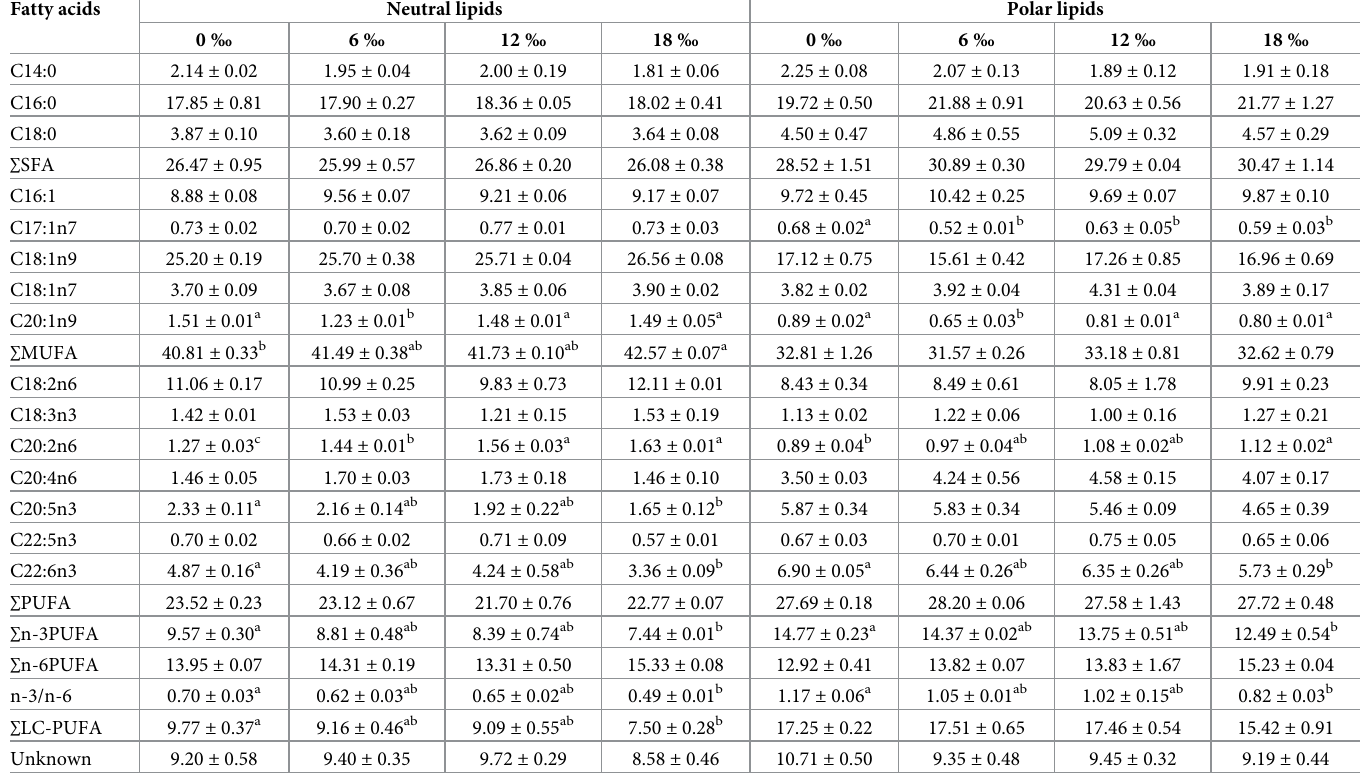
Table 4. The principal fatty acid profiles (% total fatty acids) of the neutral lipids and polar lipids in the hepatopancreas of adult male E . sinensis . Fatty acids Neutral lipids Polar lipids